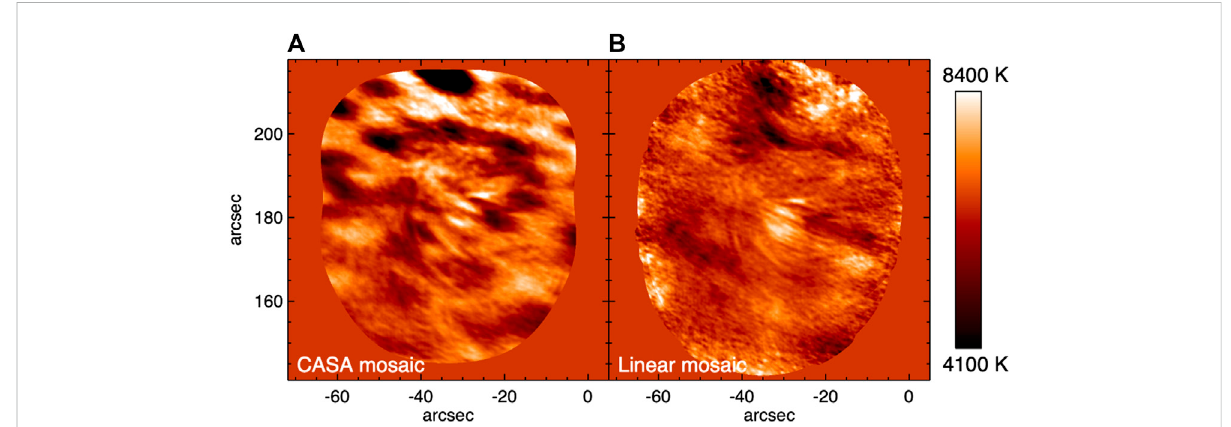
FIGURE 7 Example of a small mosaic formed from ten discrete pointings in 80 s. (A) : The image produced by joint deconvolution of the ten pointings in CASA. (B) : The image produced by imaging each pointing separately and combining them linearly.